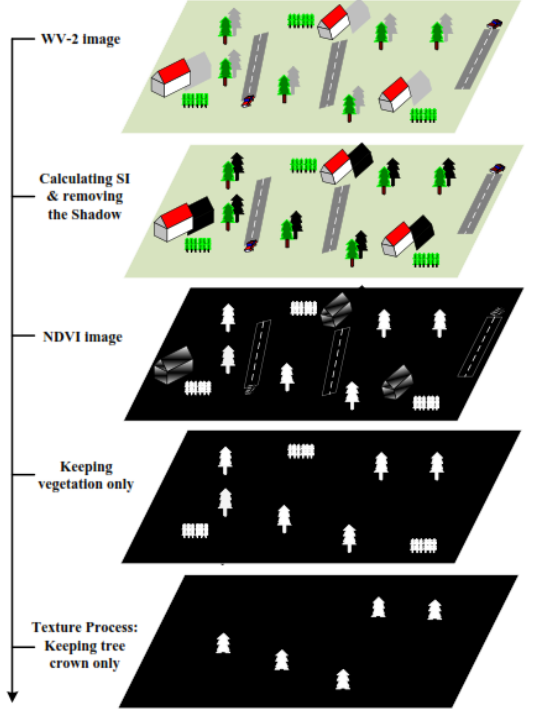
Figure 3: Schematic representation of a tree crown identification in an urban